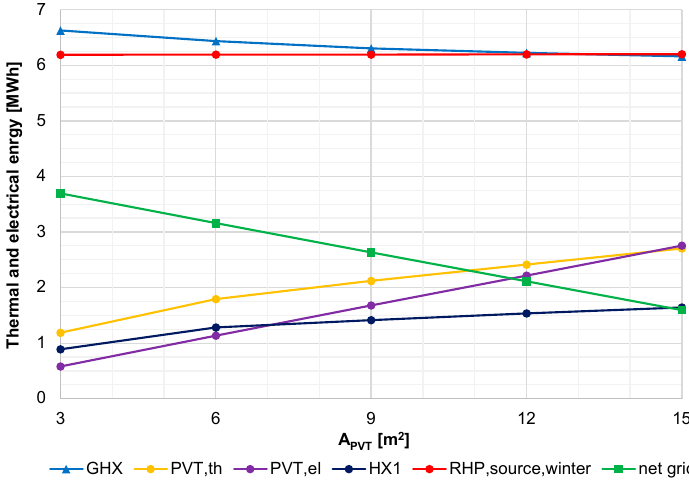
Figure 12. Main thermal and electrical energies of the system vs. variation of the PVT area, parametric analysis.